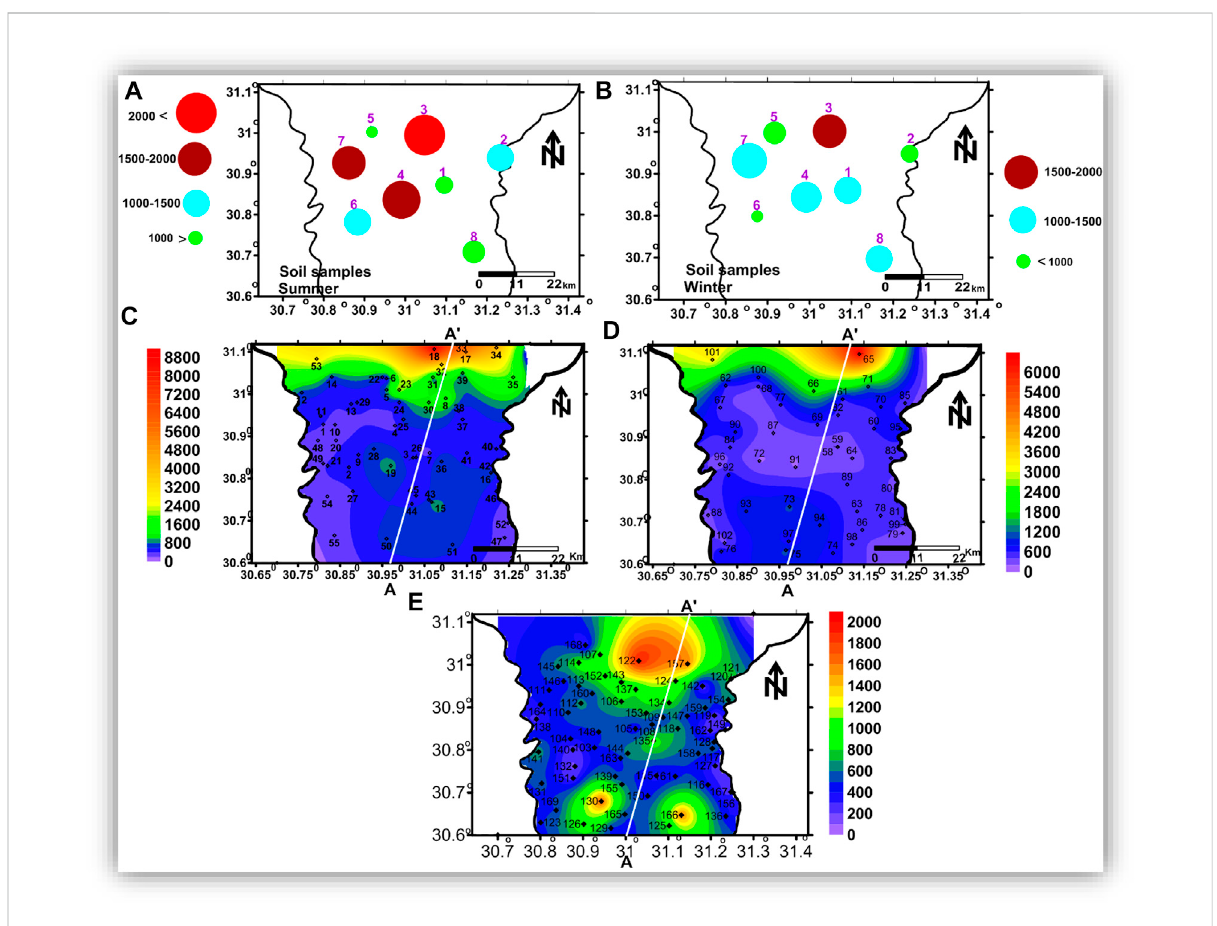
FIGURE 4 ThespatialdistributionmapsofTDSofthesoilwaterandthegroundwatersamples: (A) TDSofthesoilwaterinsummer, (B) TDSofthesoilwater in winter, and (C) , (D), and (E) TDS of the groundwater in the shallow, intermediate, and deep zones,